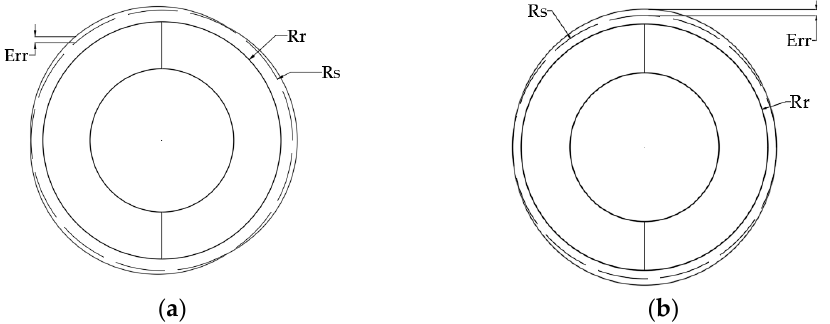
12 of 31 Figure 12. Air ‐ friction loss calculation with rotor at different speed by FE. According to the above graph, it is seen when the motor speed is low, the air friction loss is small and almost negligible. However, when the speed exceeds 15,000 r/min, the rotor air friction increases rapidly at the corresponding speed, as shown in Figure 12. It is obvious the rotor air friction loss of high ‐ speed motors accounts for a considerable relative percentage, compared with normal motors. As can be seen from Figure 12, when the motor does not provide strong cooling air, the air friction loss is only caused by the speed. The loss in the FE calculation results is proportional to the cubic power of the velocity, and the simulation results are consistent with the calculation Formulas (18) and (19). At rated speed of 36,000 r/min, the FE calcu ‐ lation result of air friction loss is 1050 W. However, when the axial cooling wind speed v is greater than 0 m/s, the air friction loss of the motor becomes the loss caused by the combined action of speed and strong air cooling through the air gap. The FE calculation results show that the larger v is, the greater the air friction loss of the motor is. Therefore, in order to reduce the air friction loss of high ‐ speed motor and ensure that the motor will not overheat, the appropriate axial cooling wind speed should be selected. 4.2. The Effect of Roundness Error on Air Friction Loss The Figure 13 shows the structure of the rotor when the sleeve produces roundness error, which is a problem caused by the outer surface of the sleeve without mechanical processing, and there are two cases that often occur in actual engineering, which are ellip ‐